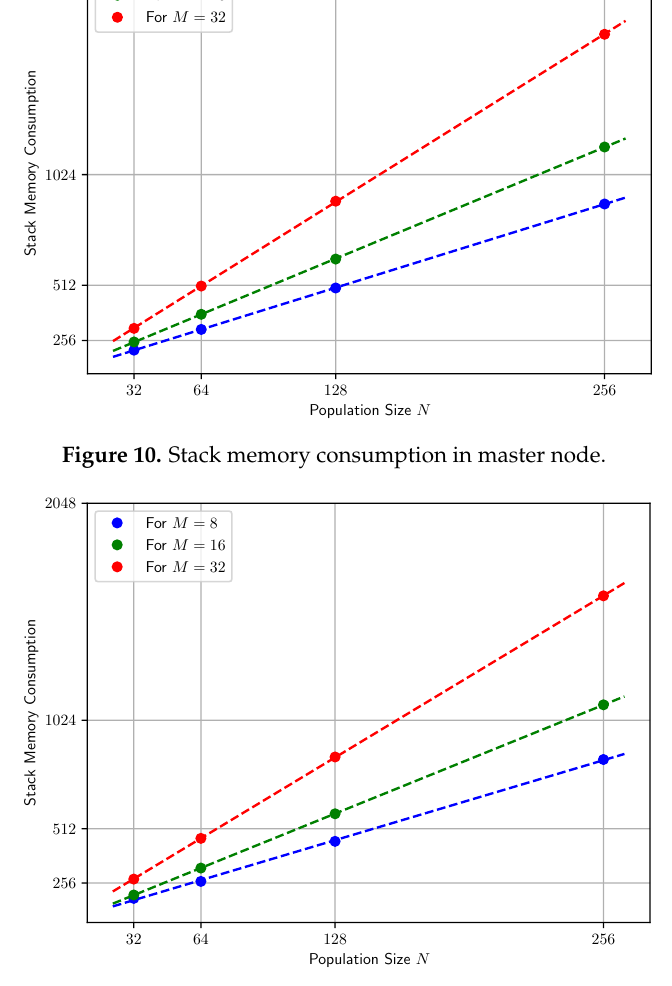
Figure 11. Stack memory consumption in slave